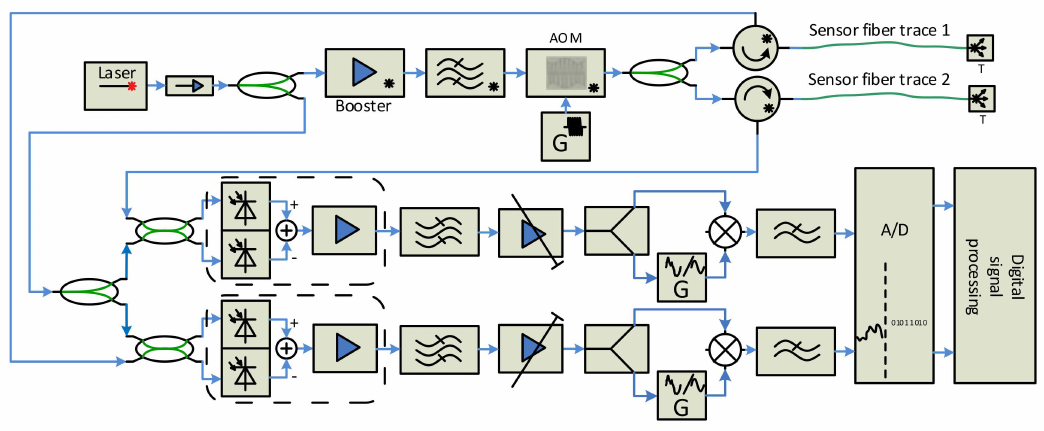
Figure 10. Two-trace sensor